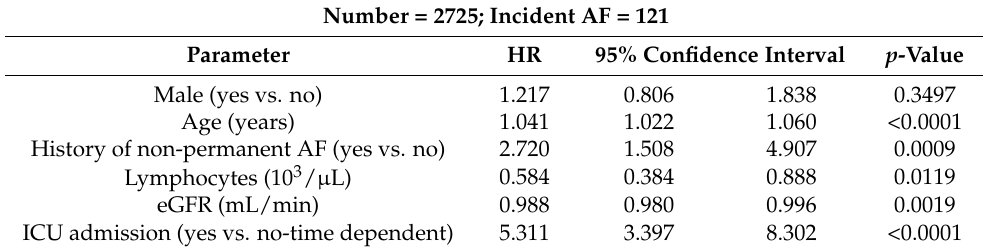
Table 2. Cox multivariable regression model on incident AF with stepwise backward variable selection (variables with p < 0.05 were retained; age, sex and history of AF were forced in the model). Patients with permanent AFs were